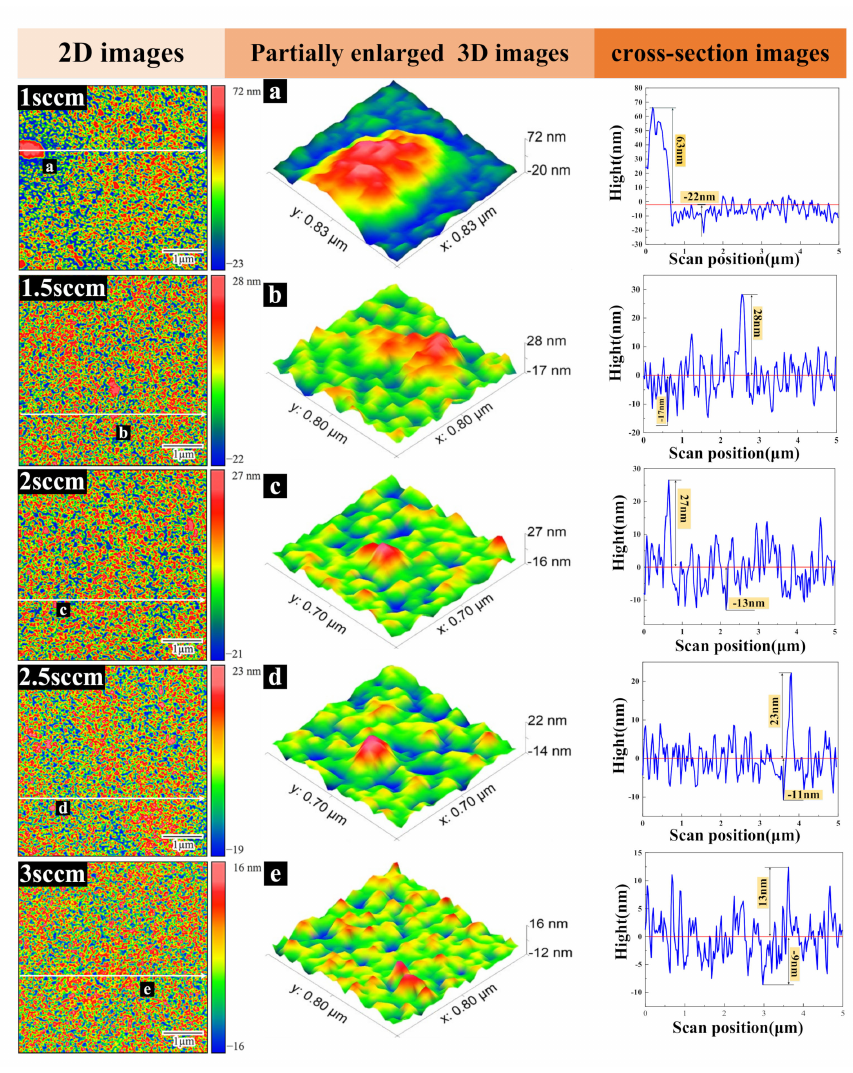
Figure 8. When the bias voltage is − 60 V, and the nitrogen flow rate is 1–3 sccm, the 2D images, 3D local partially enlarged images ( a – e ), and cross-sectional images of titanium nitride film.